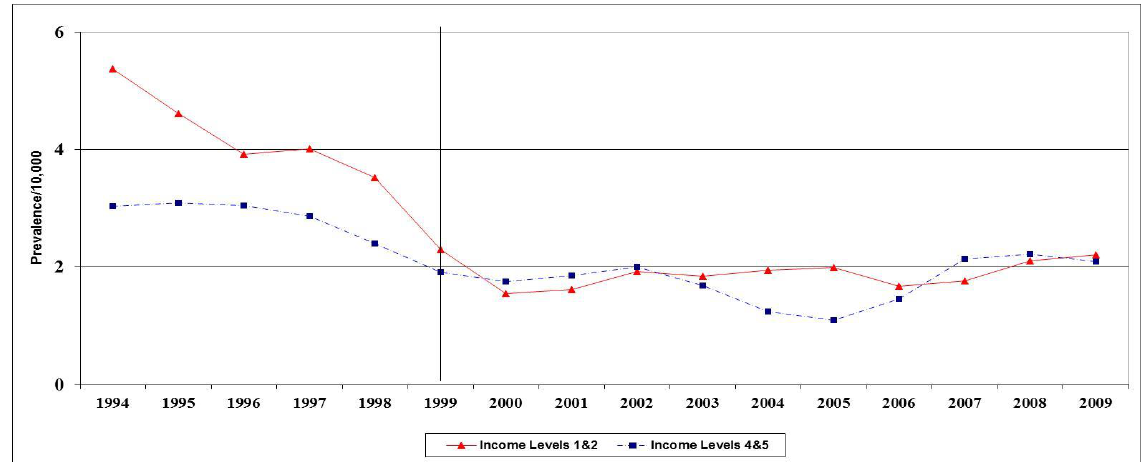
Figure 4. Birth prevalence (/10,000) of spina bifida by income quintiles in Ontario, 1994  2009.